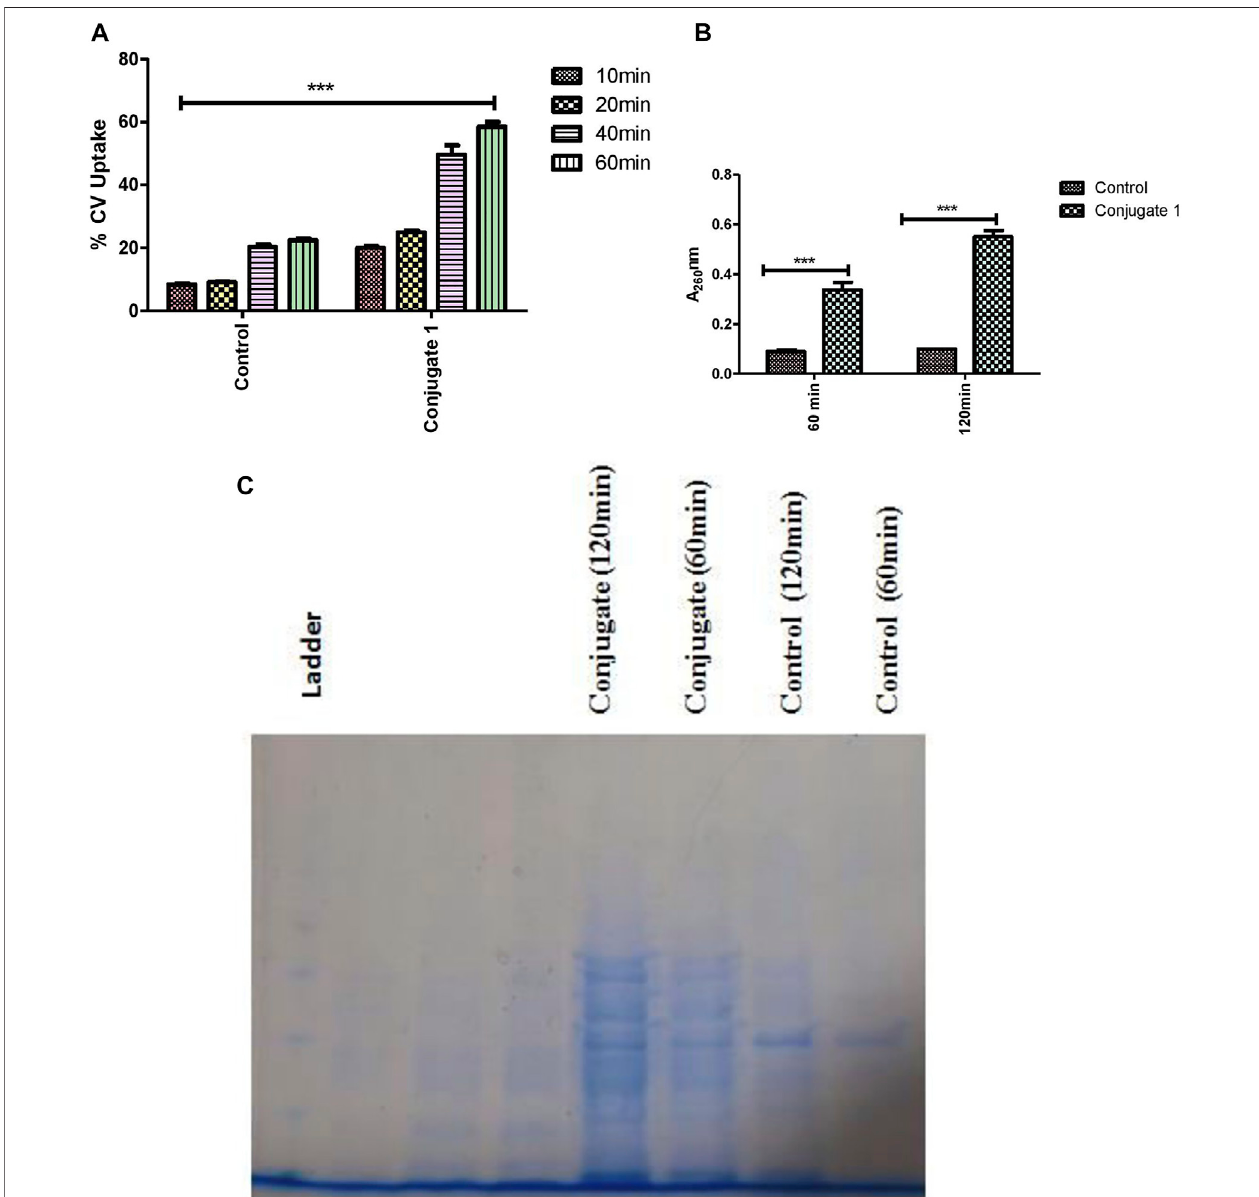
FIGURE9|(A) Crystalvioletuptakeofcatechol – zingconjugate( 1 ). (B) Effectsofcatechol – zingconjugateonreleaseofcellularmaterialson P.aeruginosa basedon absorbance recorded at 260 nm. (C) Time-dependent proteins released into the supernatant, detected by using SDS-PAGE.